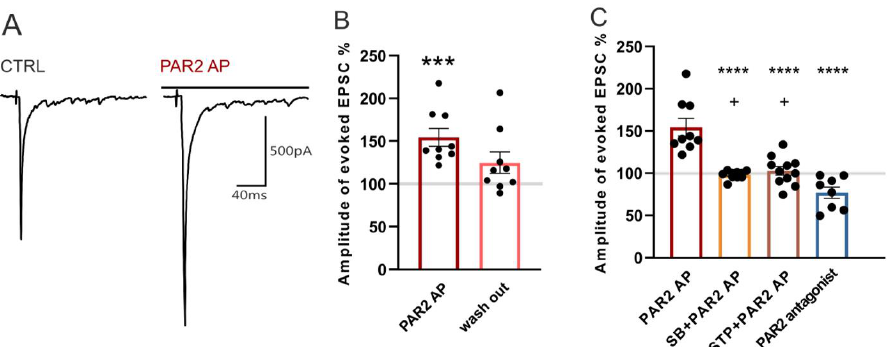
Figure 4. Activation of PAR2 increased the amplitude of EPSCs evoked by dorsal root stimulation. ( A ) Native recordings from one superficial dorsal horn neuron in an acute spinal cord slice prepared 24 h after the carrageenan injection. Application of PAR2 AP (4 min) increased the amplitude of the evoked EPSC. ( B ) The increase of the evoked EPSC (eEPSC) amplitude during the PAR2 AP application was statistically significant ( n = 9; Kruskal-Wallis one-way ANOVA, *** p < 0.001). ( C ) Pretreatment and co-application of SB 366791 (SB, n = 10) or staurosporine (STP, n = 11) with PAR2 AP prevented the PAR2 AP-induced increase of the eEPSC amplitude. Application of the PAR2 antagonist ( n = 8) decreased the eEPSC amplitude. Statistical analysis: one-way ANOVA followed by the SNK test. Statistical symbols: **** p < 0.0001 versus PAR2 AP and + p < 0.05 versus the PAR2 antagonist.